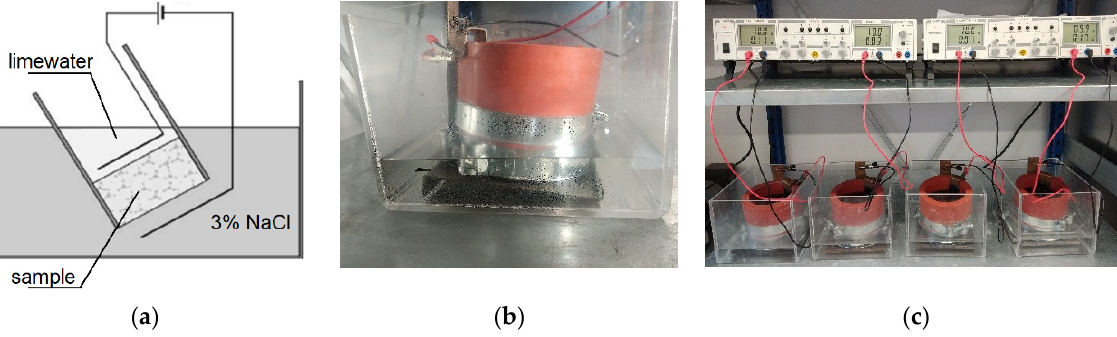
Figure 3. ( a ) NT BUILD 492 migration test scheme; ( b ) chloride migration cell; ( c ) chloride migration set-up. After completion of the test, the specimen is axially split to enable the evaluation of the penetration depth. The average value of the penetration depth (x d ) is measured after the use of the silver nitrate solution, as presented in Figure 4.